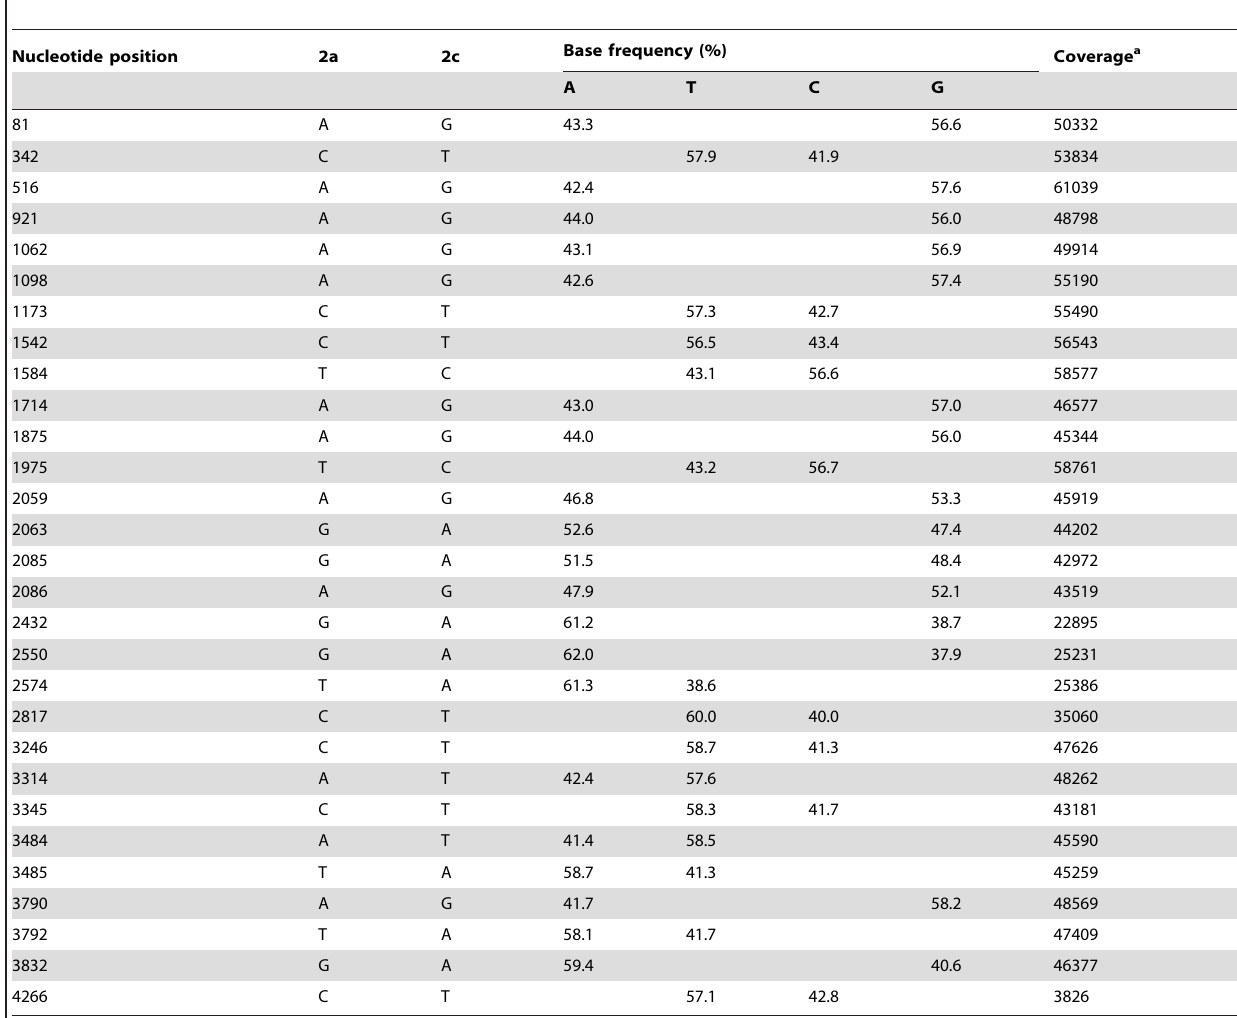
Table 2. Deep-sequencing profile of the distinguishing nucleotides between CPV-2a (KM457141) and CPV-2c (KM457142) strains in sample